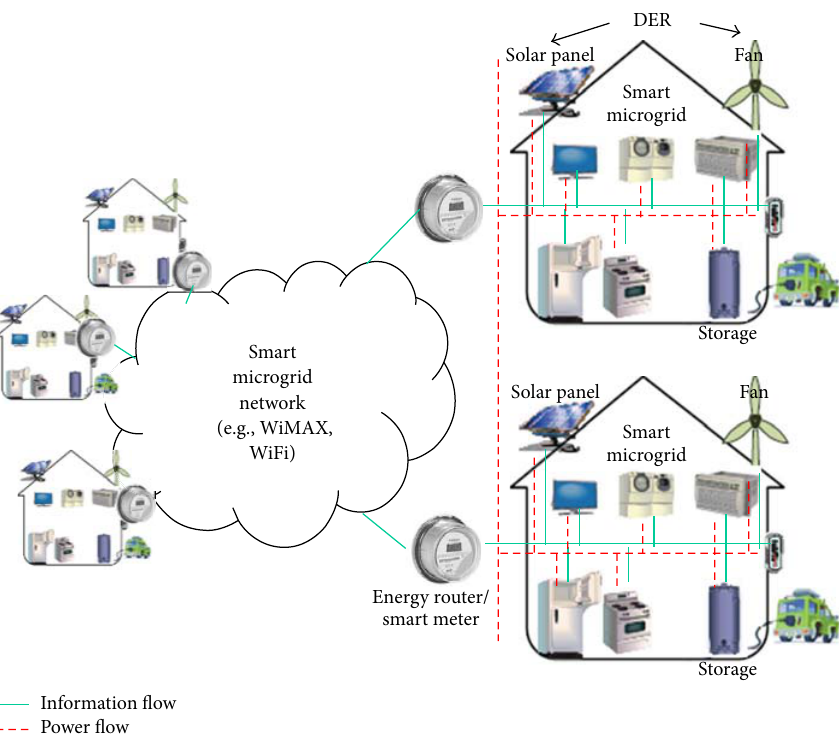
Figure 1: Smart microgrid network with renewable energy in smart